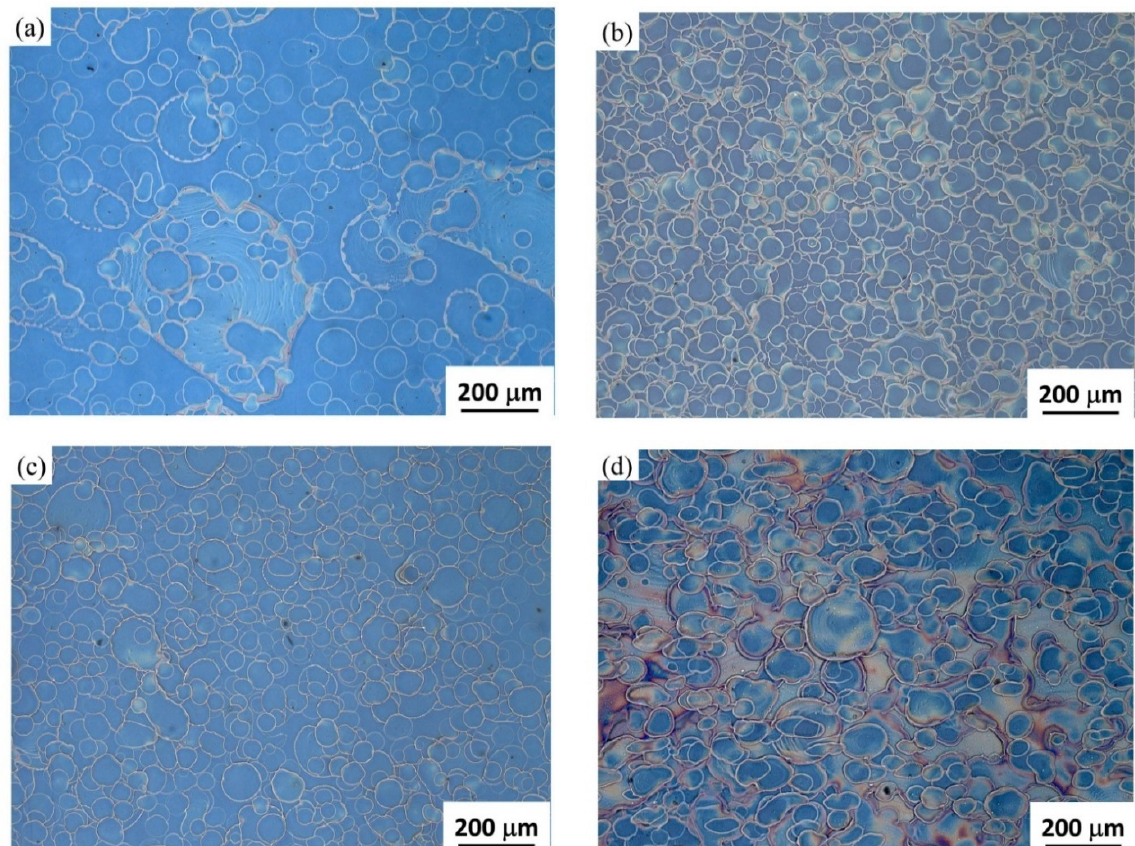
Figure 6. Effect of carrier air pressure on the film topography: 2D optical images of the surface of spray-on P3HT:PCBM films: ( a ) 0.1 MPa, ( b ) 0.2 MPa, ( c ) 0.3 MPa, and ( d ) 0.4 MPa; a single spray pass was applied in all cases. The flow rate is 1 mL/min, and the concentration is 1.8 mg/mL.